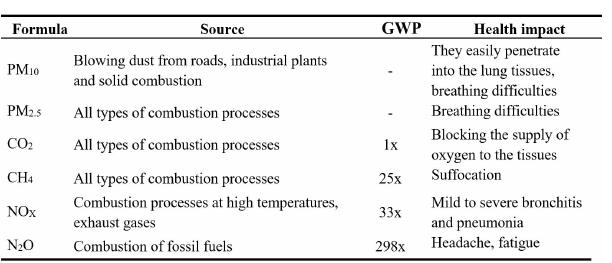
Table 1. Overview of sources of basic emission substances, their environmental and health harmfulness